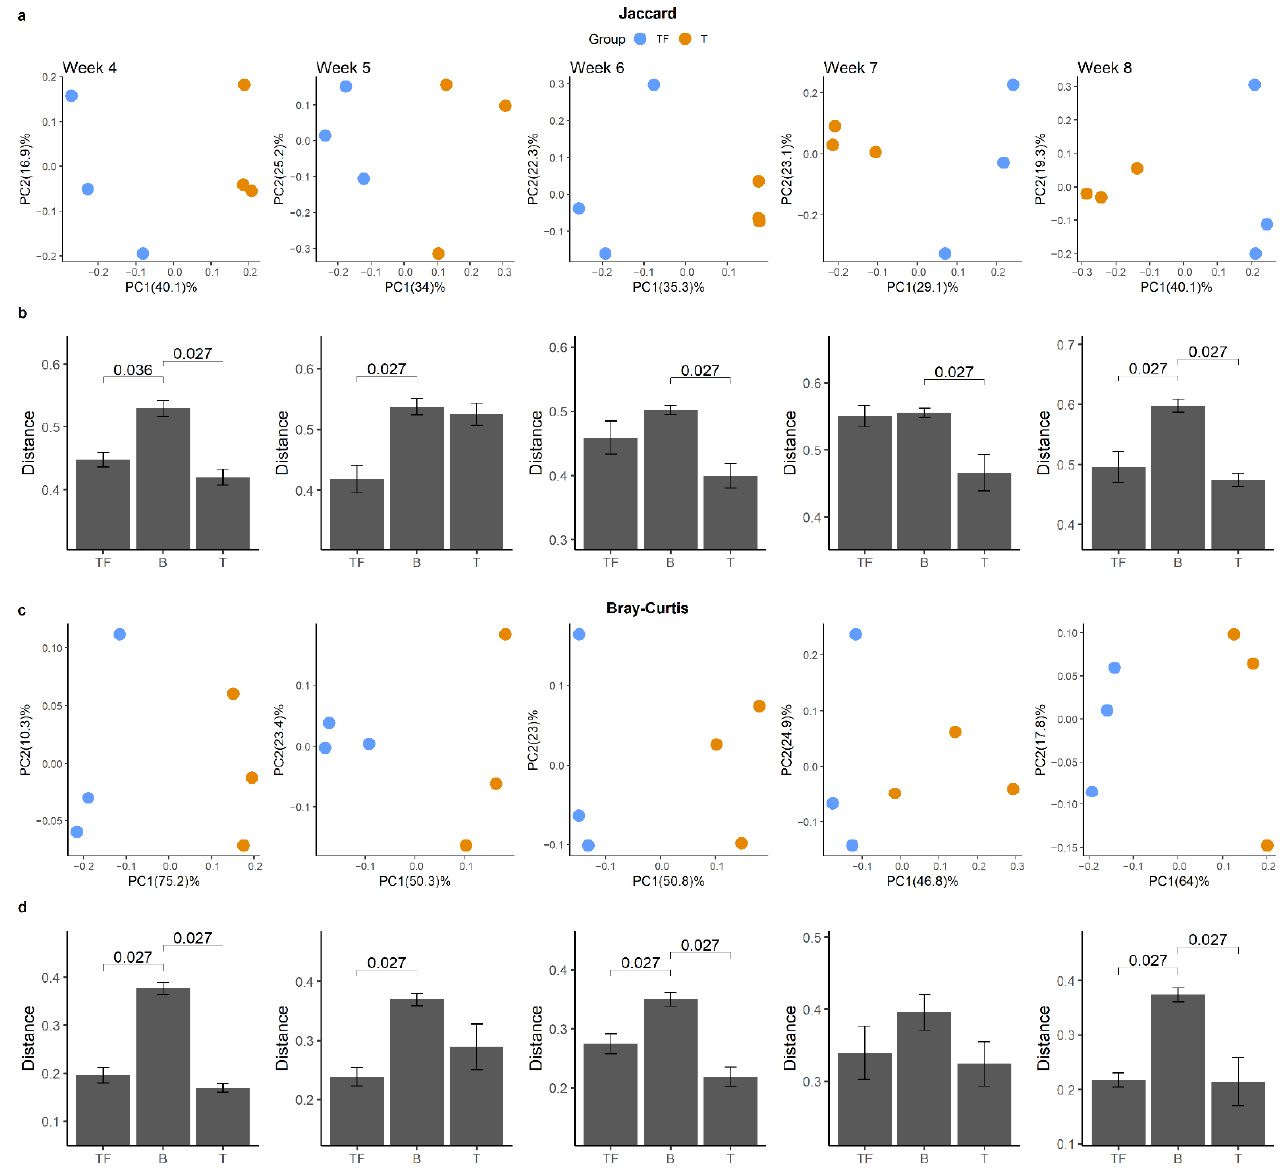
Figure 5. Beta diversity analysis for gut microbiota from two groups at different time points. PCoA plots derived from ( a ) Jaccard distance and ( c ) Bray–Curtis distance for the five time points show the separation between T and TF groups. The distribution of Jaccard ( b ) and Bray–Curtis ( d ) beta-diversity distances within and between T and TF groups reveals the difference between T and TF at different time points. The distances within TF and T groups are noted as TF and T, respectively, while the distance between TF and T groups is noted as B. p values derived from Wilcoxon rank-sum test are shown in the bar